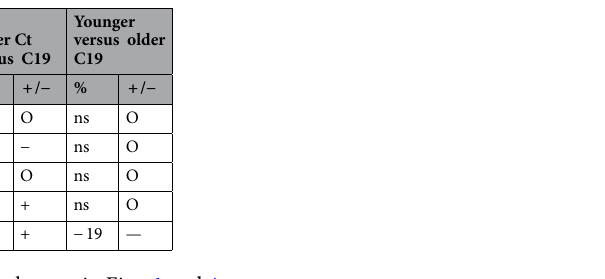
Table 2. Summary of per cent power changes in Figs. 1 and 4.